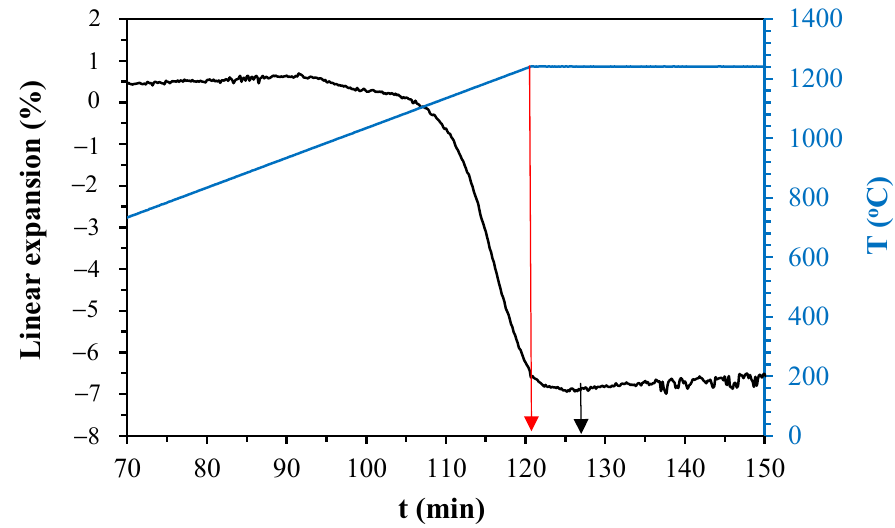
The X-ray diffractograms of all the compositions (C0, C1, C2, and C3), and the firing temperatures studied are shown in Figure 9. Figure 8. Linear expansion as a function of holding time of C0 at 1220 ◦ C. Figure 8. Linear expansion as a function of holding time of C0 at 1220 °C.